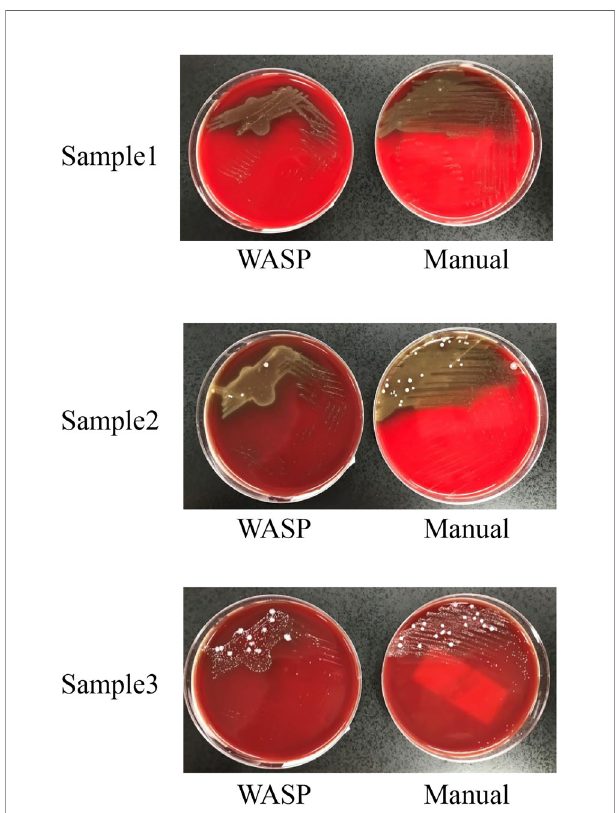
FIGURE 1 | Difference in streaking patterns between Copan wasp and manual